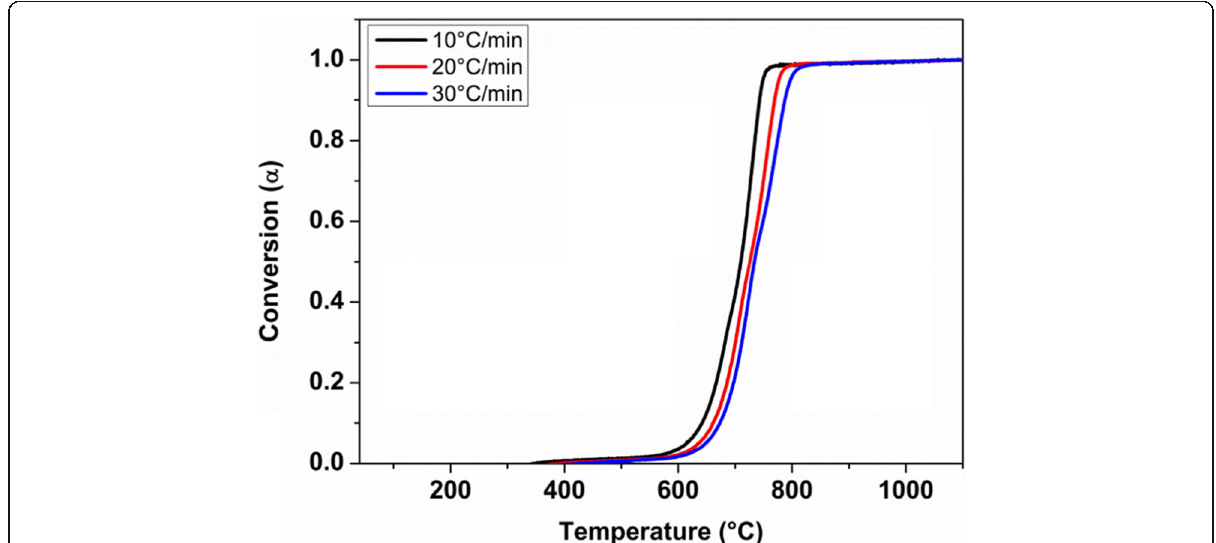
Fig. 4 Variation of α for TGA